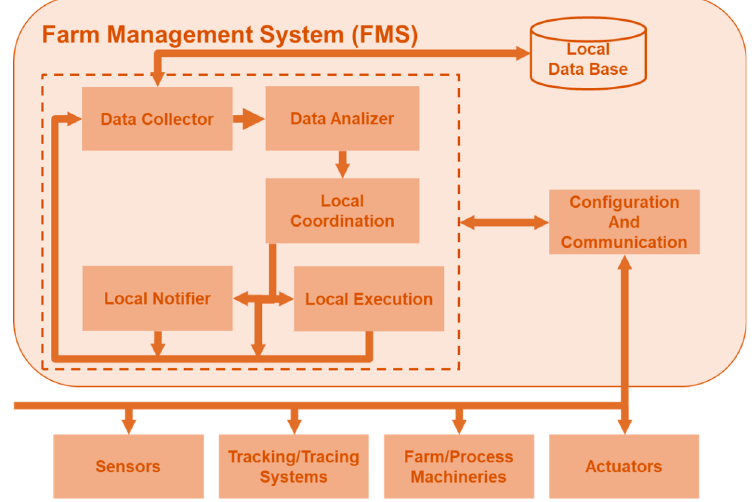
Figure 5. Agriculture 4.0. Structure of a management system (FMS) by virtualization of an agri-food chain.